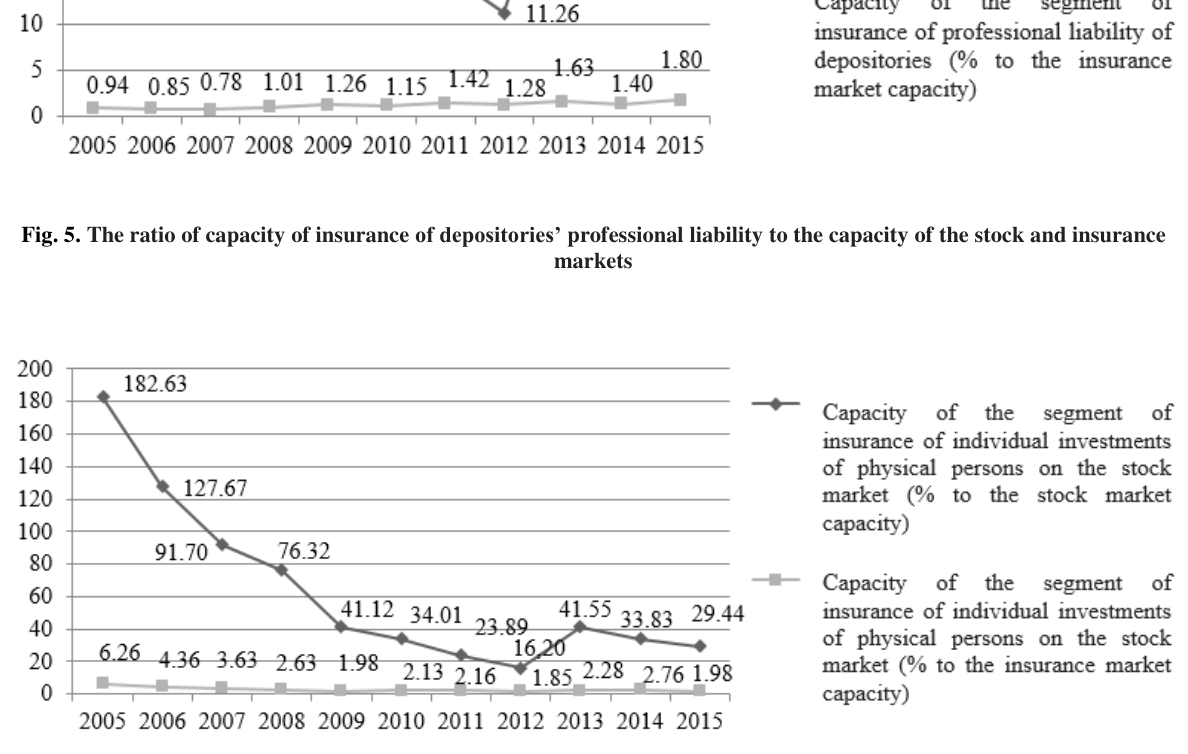
Fig. 6. The ratio of the volume of insurance of individual investments of physical persons on the stock market to the capacity of the stock and insurance